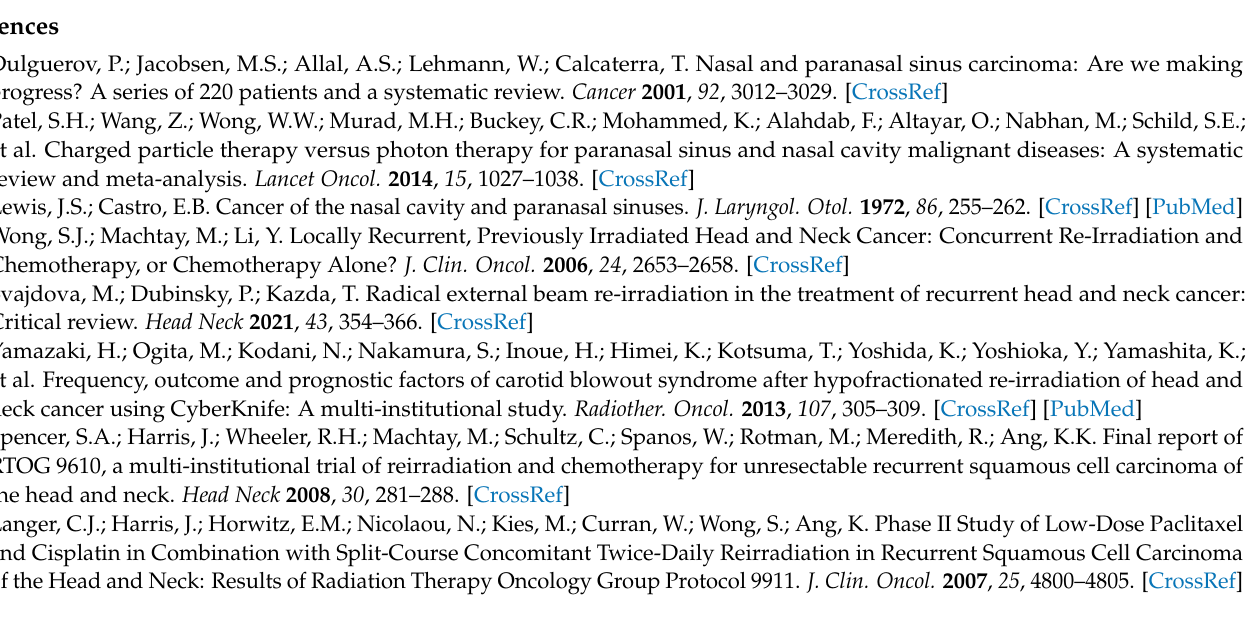
Table S4: Correlation between prescribed dose and toxicity, Table S5: Correlation between prescribed dose and toxicity